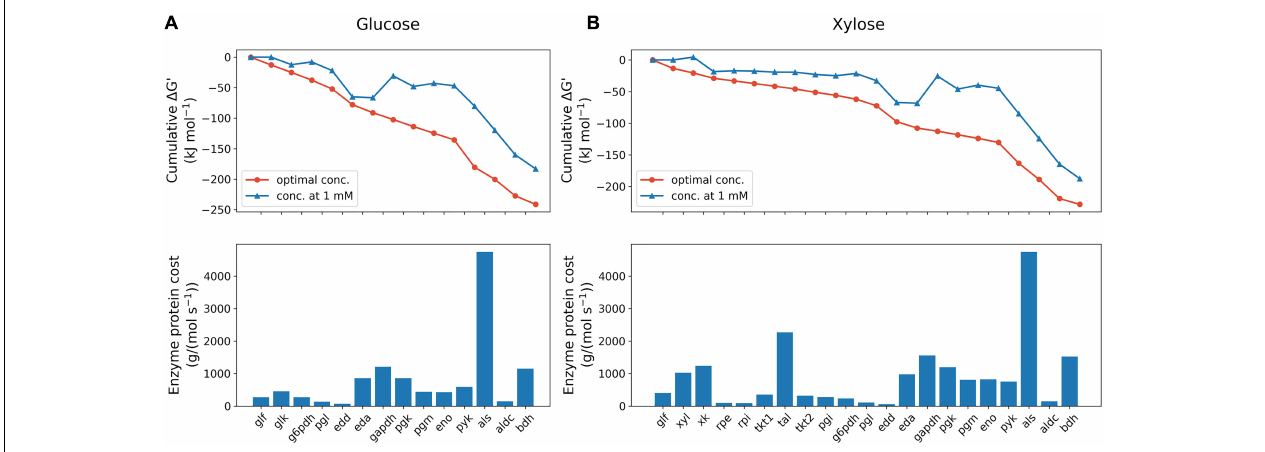
FIGURE 2 | Max-min driving force (MDF) optimization (upper panels) and enzyme protein cost estimation (lower panels) of glucose (A) and xylose (B) metabolism pathway of Z. mobilis BC42C (cid:49) pdc at the initial state. MDF optimization is presented as the cumulative sum of reaction Gibbs free energies, (cid:49) G (cid:48) . Blue line with triangle symbols denotes standard Gibbs free energies with all metabolite concentrations fixed at 1 mM, and red line with circle symbols denotes Gibbs free energies when the minimal (cid:49) G (cid:48) is optimized with metabolite concentrations constrained ranging from 1 µ M to 10 mM except that extracellular glucose/xylose concentration fixed at measured value. Enzyme protein costs were optimized for the minimal protein mass required to support unit pathway flux under the same concentration constraints with MDF optimization. eda, 2-dehydro-3-deoxy-phosphogluconate aldolase; edd, phosphogluconate dehydratase; eno, enolase; g6pdh, glucose-6-phosphate dehydrogenase; gapdh, glyceraldehyde-3-phosphate dehydrogenase; glf, glucose facilitator protein; glk, glucokinase; pgi, glucose-6-phosphate isomerase; pgl, 6-phosphogluconolactonase; pgm, phosphoglycerate mutase; pgk, phosphoglycerate kinase; pyk, pyruvate kinase; rpe, ribulose-5-phosphate epimerase; rpi, ribose-5-phosphate isomerase; tal, transaldolase; tkt, transketolase; xk, xylulokinase; xyl, xylose isomerase.